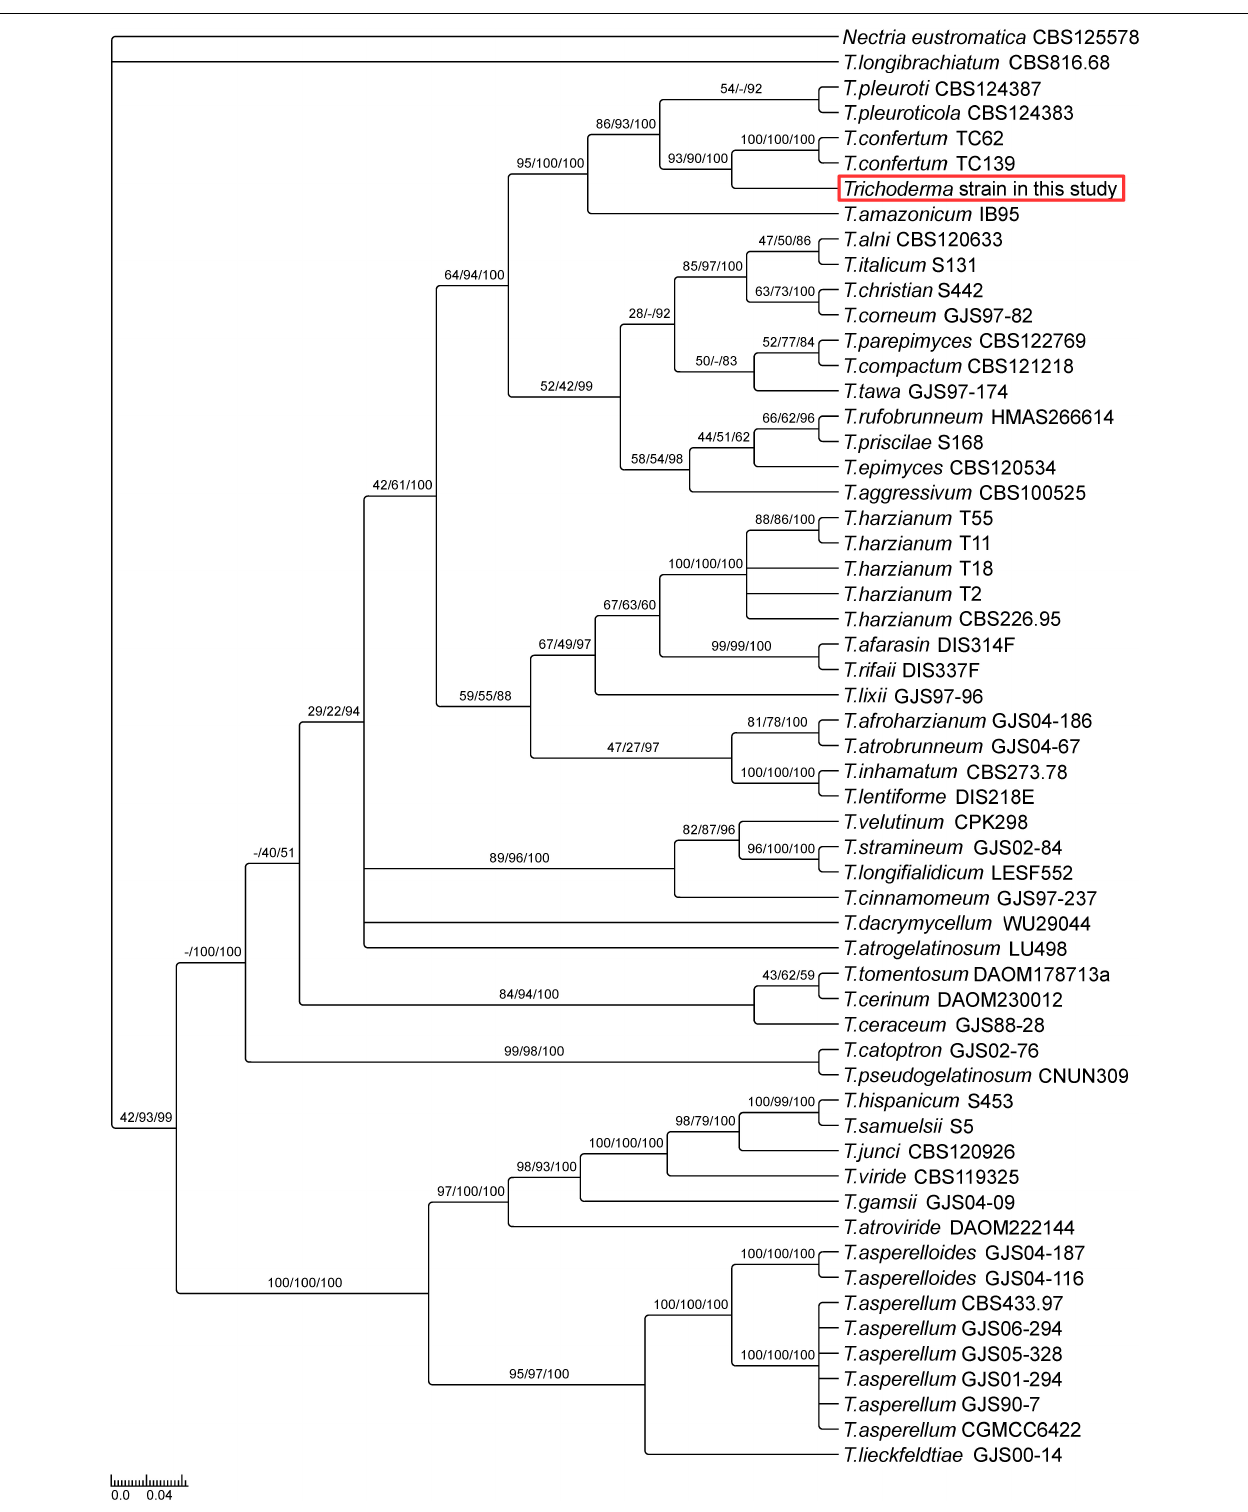
FIGURE 1 | Phylogeny of selected Trichoderma species suggests a new Trichoderma strain closely related to T. confertum . The phylogenetic tree is based on combined analysis of TEF1 and RPB2 genes using Bayesian inference of phylogeny. Maximum likelihood bootstrap values (MLBP, left), maximum parsimony bootstrap values (MPBP, center) and Bayesian inference posterior probabilities (BIPP, right) are shown at each node. Nectria eustromatica was used as outgroup.